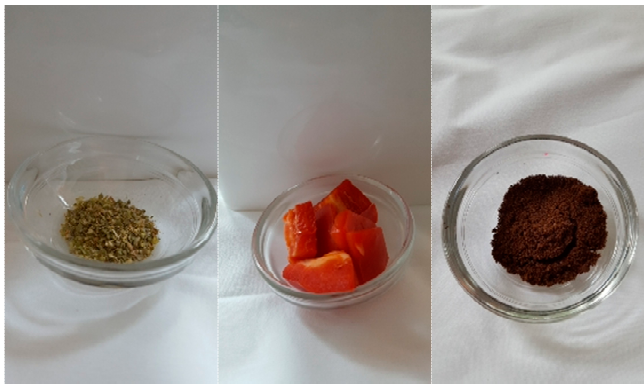
Foods 2019 , 8 , x FOR PEER REVIEW Figure 2. The served samples in the emotional profiling (taste test). Figure A2. The served samples in the emotional profiling (taste test).